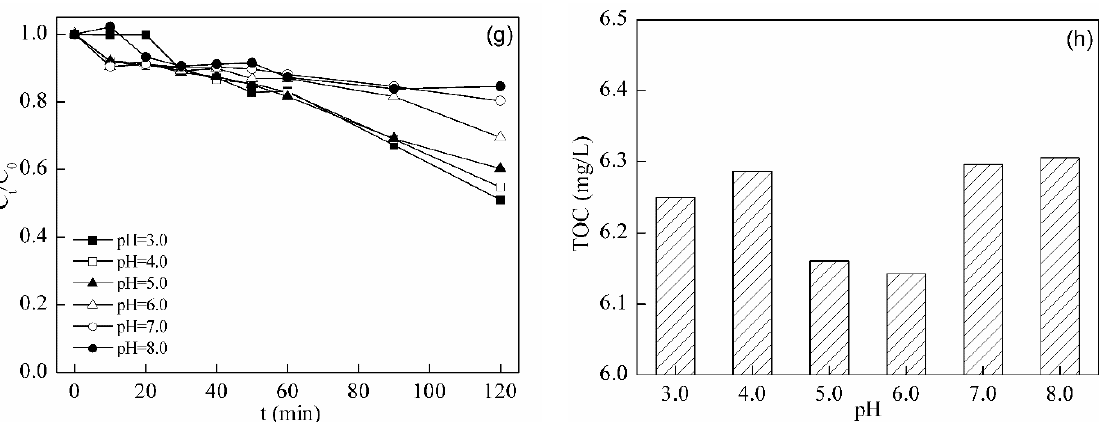
Figure 5. ( a ) Degradation and ( b ) removal kinetics of TC in the BFO-catalyzed Fenton-like system at different H 2 O 2 dosages; ( c ) Residual TOC after adsorption and Fenton-like degradation (initial TC concentration = 10.0 mg/L, initial BFO concentration = 0.5 g/L, pH = 3.0); ( d ) Degradation and ( e ) removal kinetics of TC in the BFO-catalyzed Fenton-like system at different initial pH values; ( f ) Residual TOC after adsorption and Fenton-like degradation (initial TC concentration = 10.0 mg/L, initial BFO concentration = 0.5 g/L, initial H 2 O 2 concentration = 0.5 mM); ( g ) Degradation and ( h ) residual TOC of TC with H 2 O 2 only at different pH values in the dark (initial TC concentration = 10.0 mg/L, initial H 2 O 2 concentration = 0.5 mM, time = 120 min).